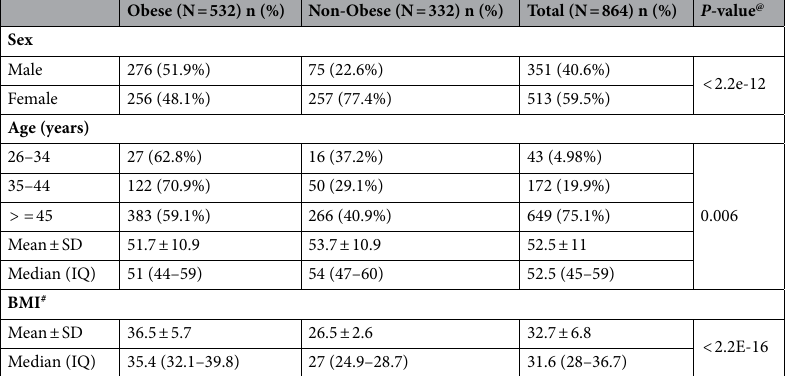
Table 1. Clinical characteristics of the Qatari cohort study. @ P -value for age categories for obese versus non- obese groups were calculated using Mann–Whitney U test. P -value for sex counts in obese versus non-obese groups were calculated using Chi-sq test. Abbreviations: BMI, body mass index; N, number of individuals; SD, standard deviation; IQ, inter-quartile. # The distribution of the participants onto normal weight (BMI 20 to < 25): overweight (BMI 25 to < 30): obese (BMI 30 to < 40): morbid obese (BMI ≥ = 40) = 88: 224: 253: